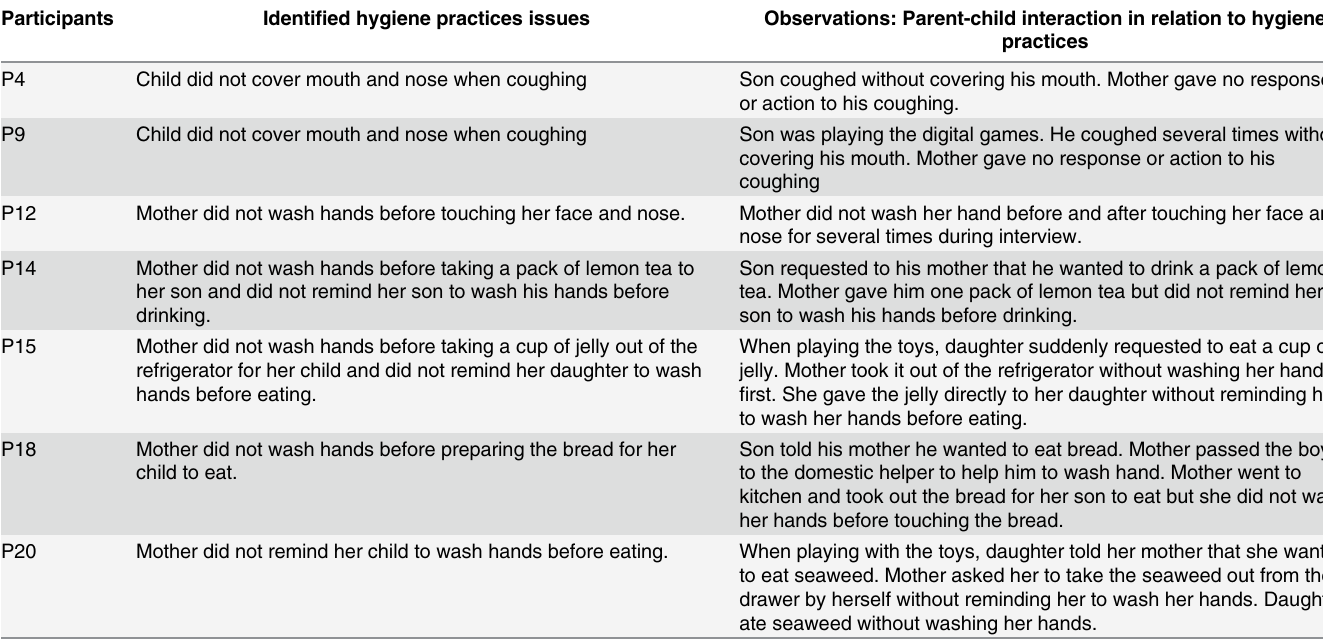
Table 3. Observations on parent-child interaction in relation to health